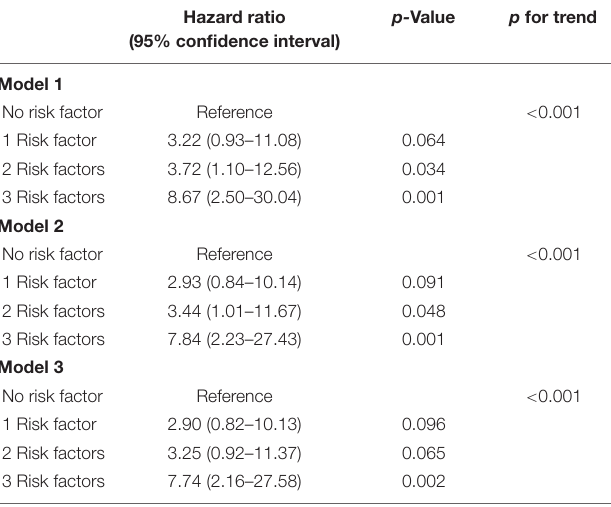
TABLE 3 | Hazard ratio of cluster risks to predict participants transition from robust to